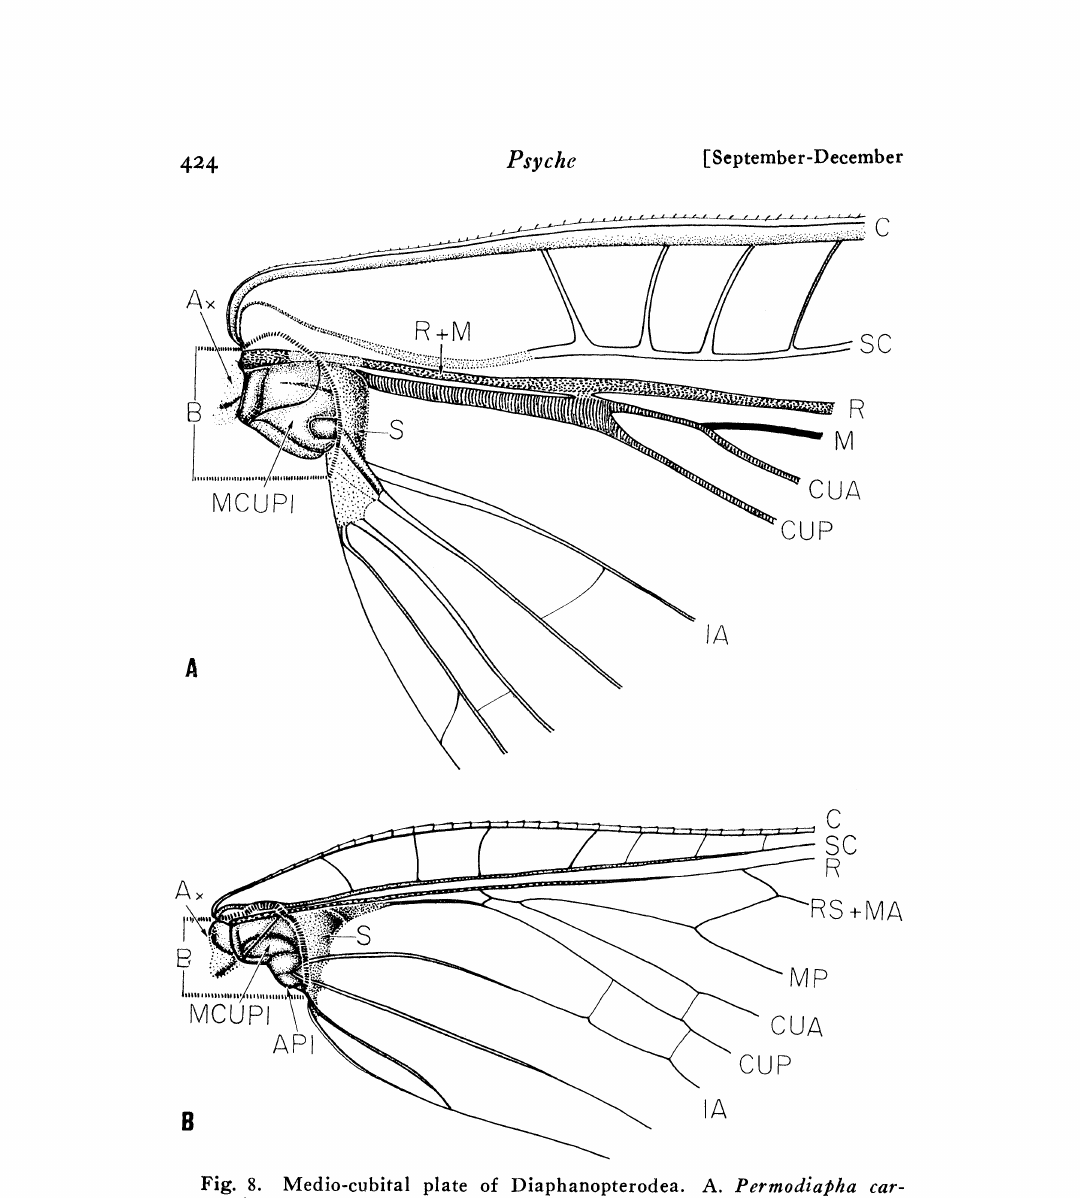
Fig. 8. Medio-cubital plate of Diaphanopterodea. A. Permodiapha car- penteri (Elmoidae), hind wing. After Kukalova-Peck, 1974. B. Marty- noia protohymenoides (Martynoviidae), fore wing. Original. AP1-- anal plate; Ax--axillary sclerite; Bmbasal fold; MCuPl--medio- eubital plate; S--sclerotized region. Lower Permian, Czechoslovakia and